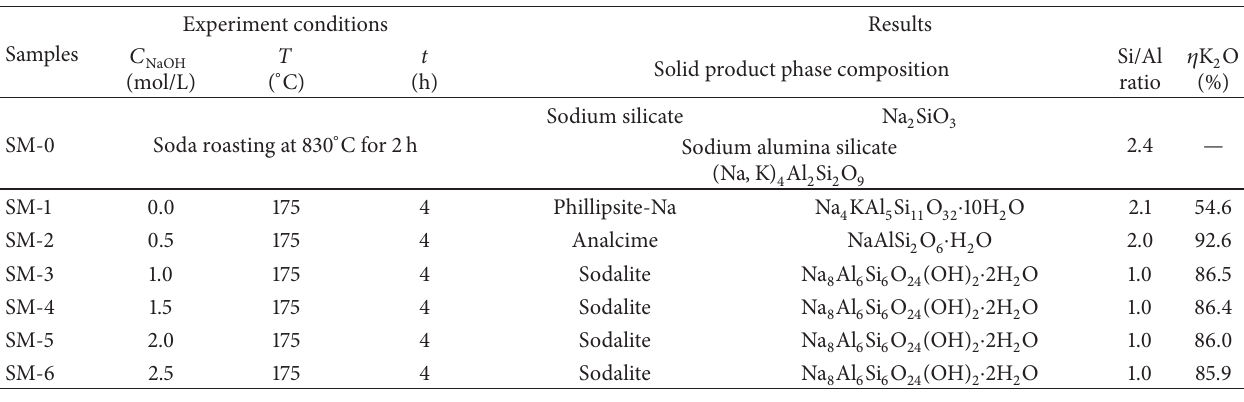
Table 2: The phase composition of as-prepared product and the extraction rates of potassium under different concentrations of NaOH solution.